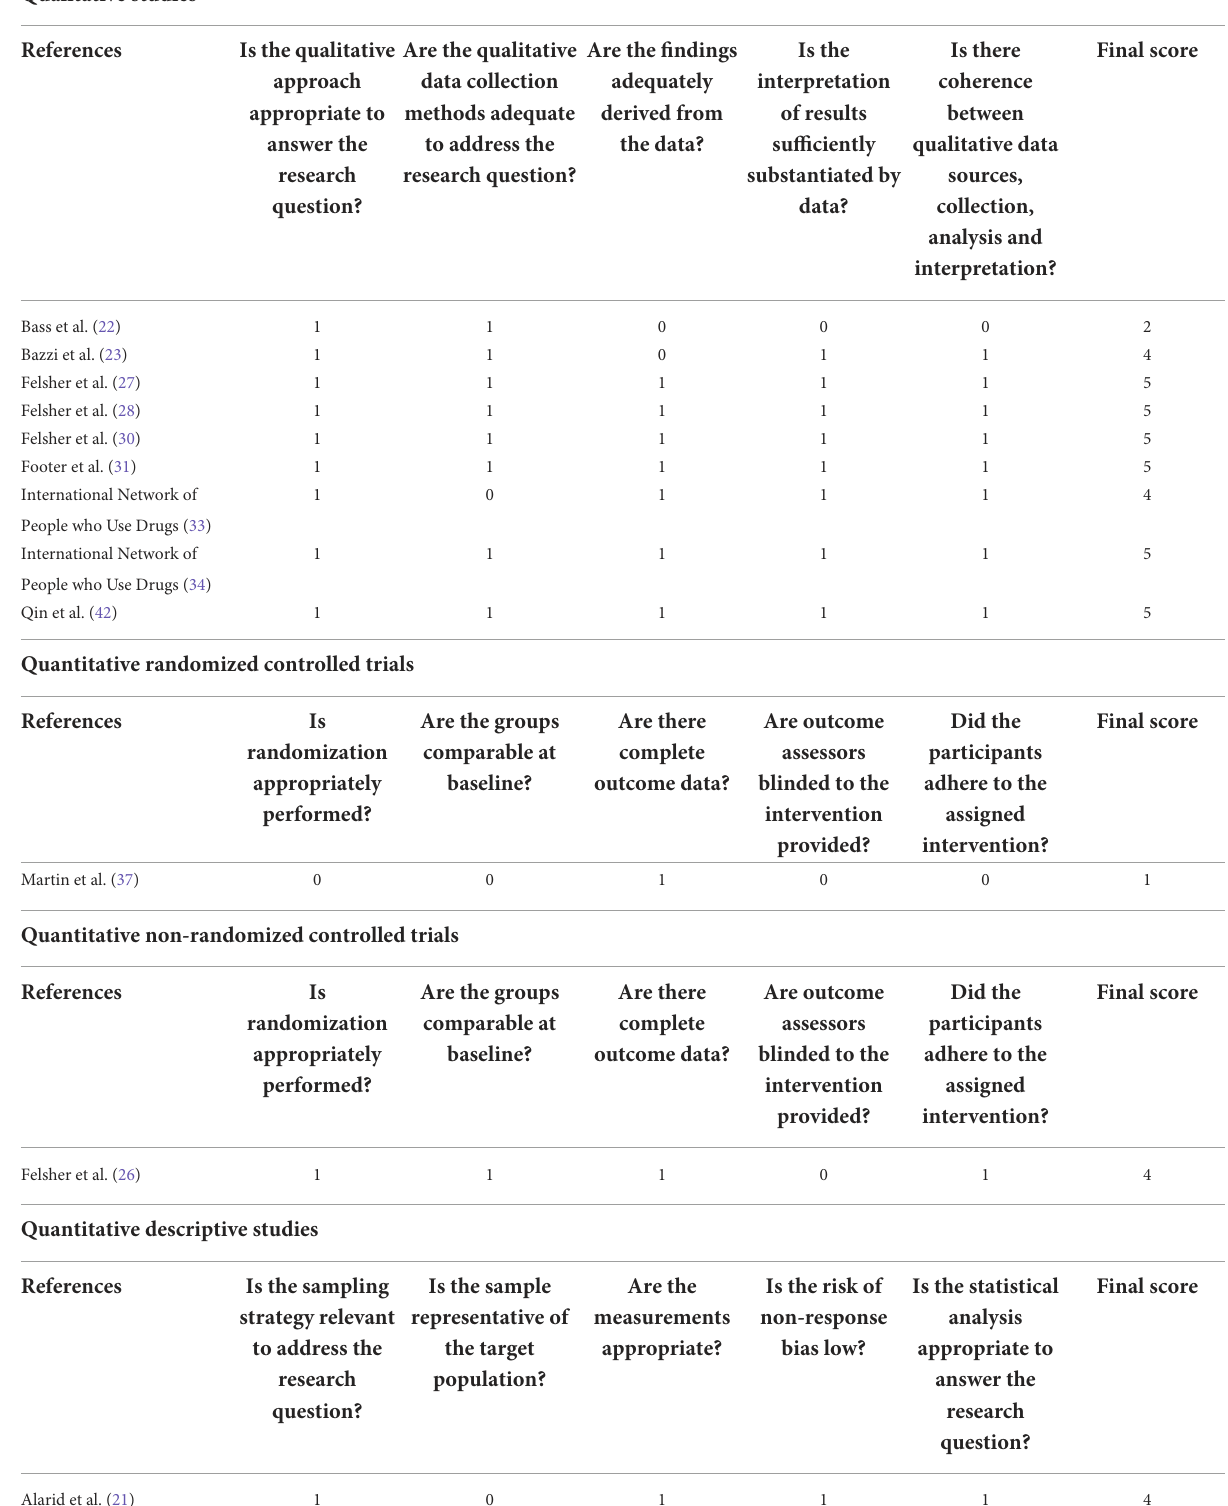
TABLE 3 Risk of bias assessment using mixed methods appraisal